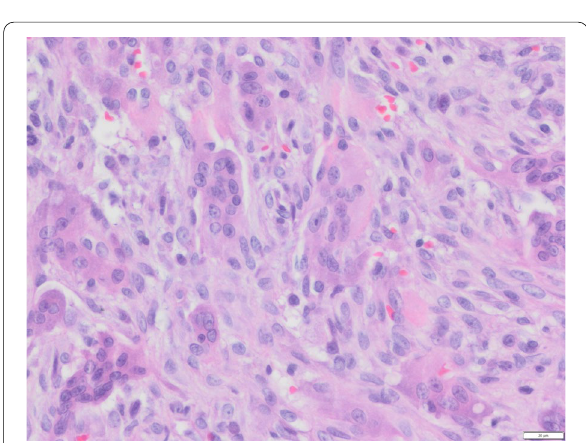
Fig. 7 Hematoxylin and eosin with osteoclast-type multinucleated giant cells in a hypercellular mesenchymal